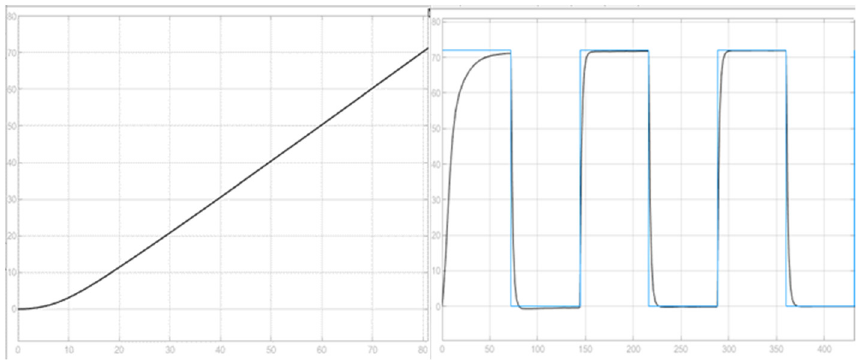
Figure 38. Response of the packaging process to a ramp input and a pulse generator, n =